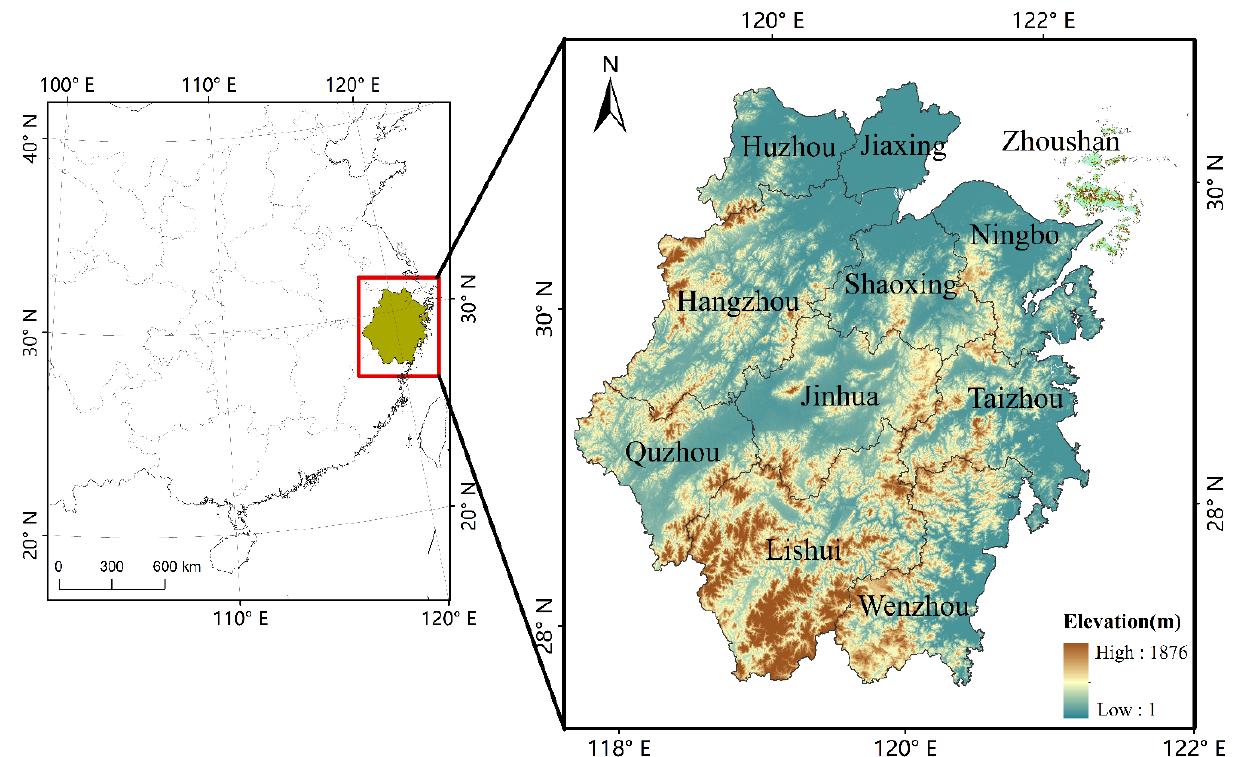
Figure 1. The location and elevation from the ASTER Global Digital Elevation Model (ASTER GDEM 30M) of the study area.